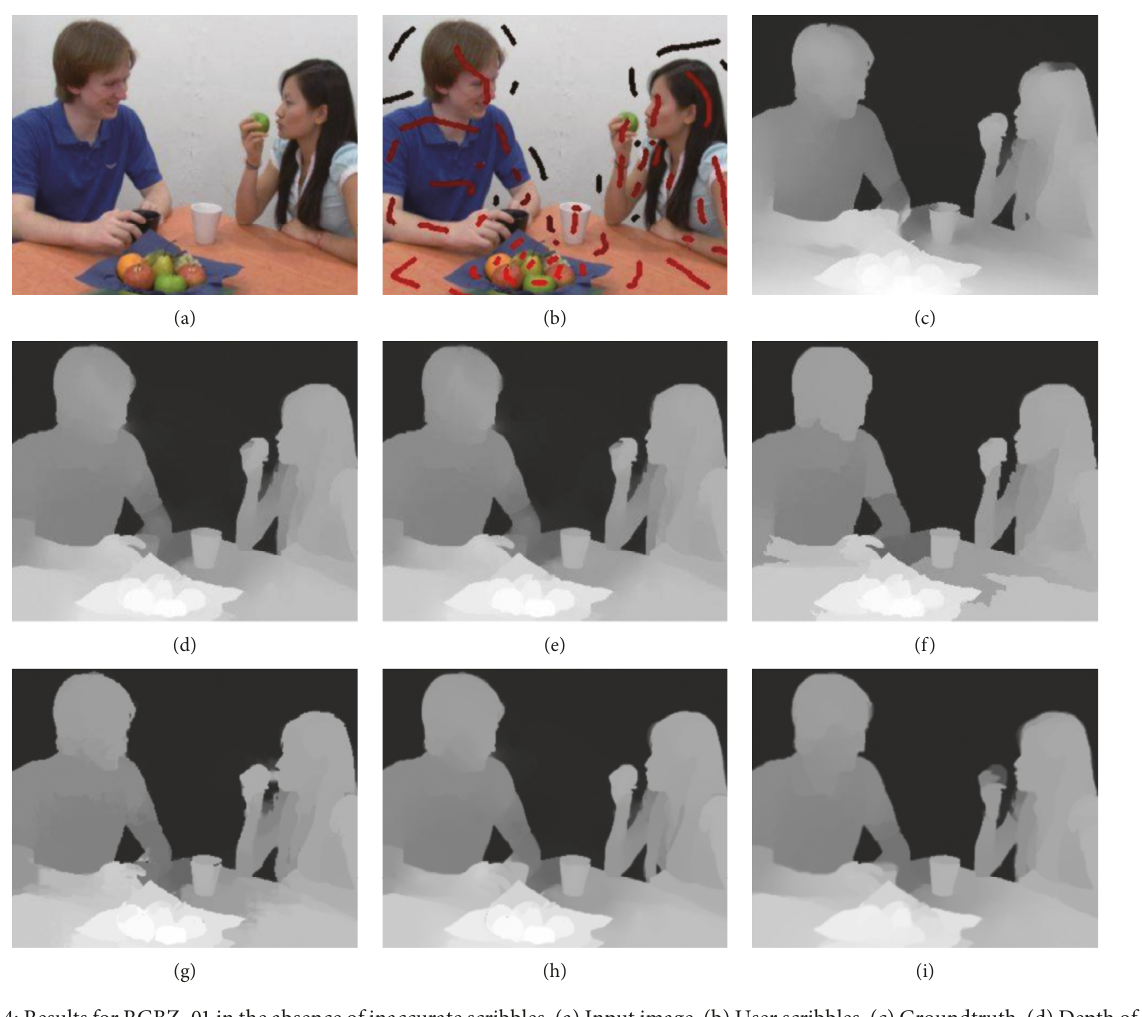
Figure 4: Results for RGBZ_01 in the absence of inaccurate scribbles. (a) Input image. (b) User scribbles. (c) Groundtruth. (d) Depth of RW [4]. (e) Depth of OPT [6]. (f) Depth of HGR [10]. (g) Depth of SOPT [13]. (h) Depth of NRW [14]. (i) Depth of